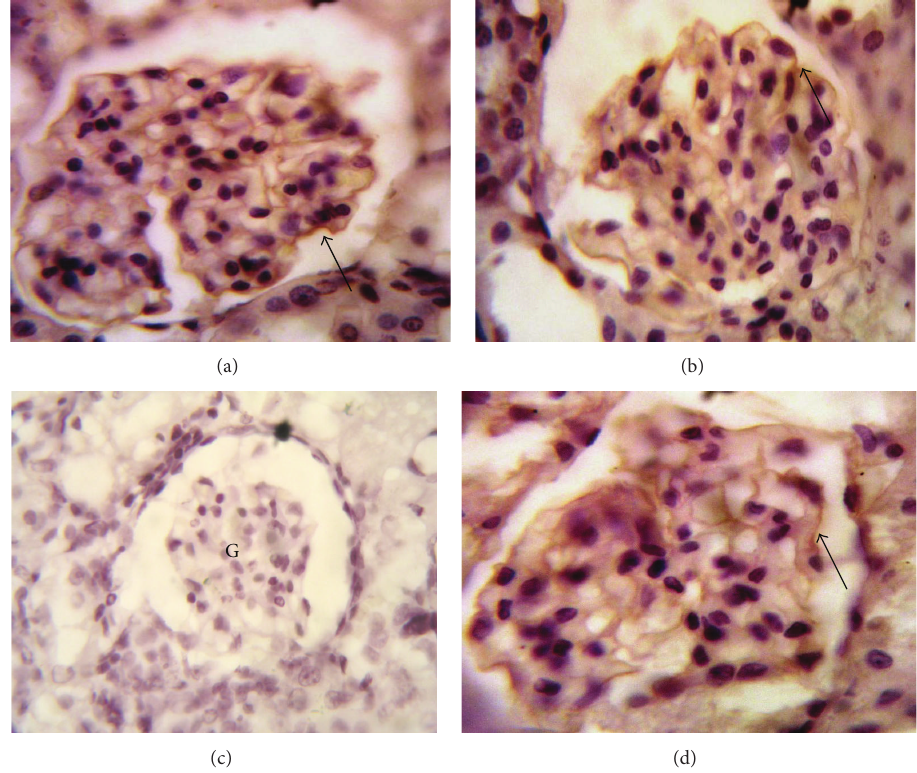
Figure 4: Effect of sildenafil on endothelial nitric oxide synthase (eNOS) immunohistochemical staining of gentamicin-treated rat kidney ( × 1000).LocalizationofeNOSimmunoreactivityinthekidneycortexof(a)and(b)controlandsildenafil-treatedgroups,respectively,showing positive immunoreactivity in the glomerulus endothelium (arrow), (c) gentamicin-treated group showing absent immunoreactivity within the renal glomerulus (G), and (d) gentamicin and sildenafil-treated group showing immunoreactivity within the renal glomerulus